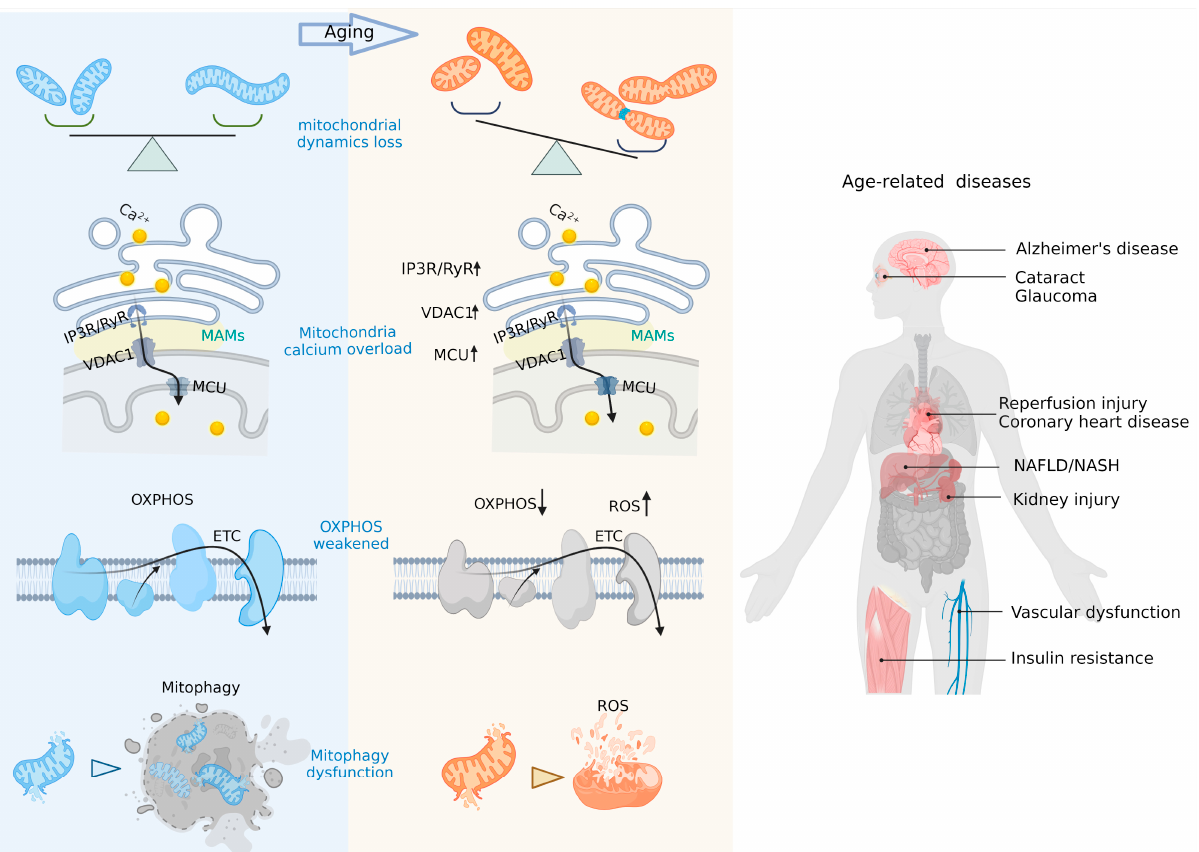
Figure 2. Mitochondrial biology in age-related disorders. Abbreviations: MAMs, mitochondria- associated endoplasmic reticulum membranes; MCU, mitochondrial calcium uniporter; VDAC1, voltage-dependent anion channel 1; IP3R, inositol 1,4,5-trisphosphate receptor; RyR, ryanodine receptor; OXPHOS, oxidative phosphorylation; ETC, electron transport chain; NAFLD, non-alcoholic fatty liver disease; NASH, non-alcoholic steatohepatitis.